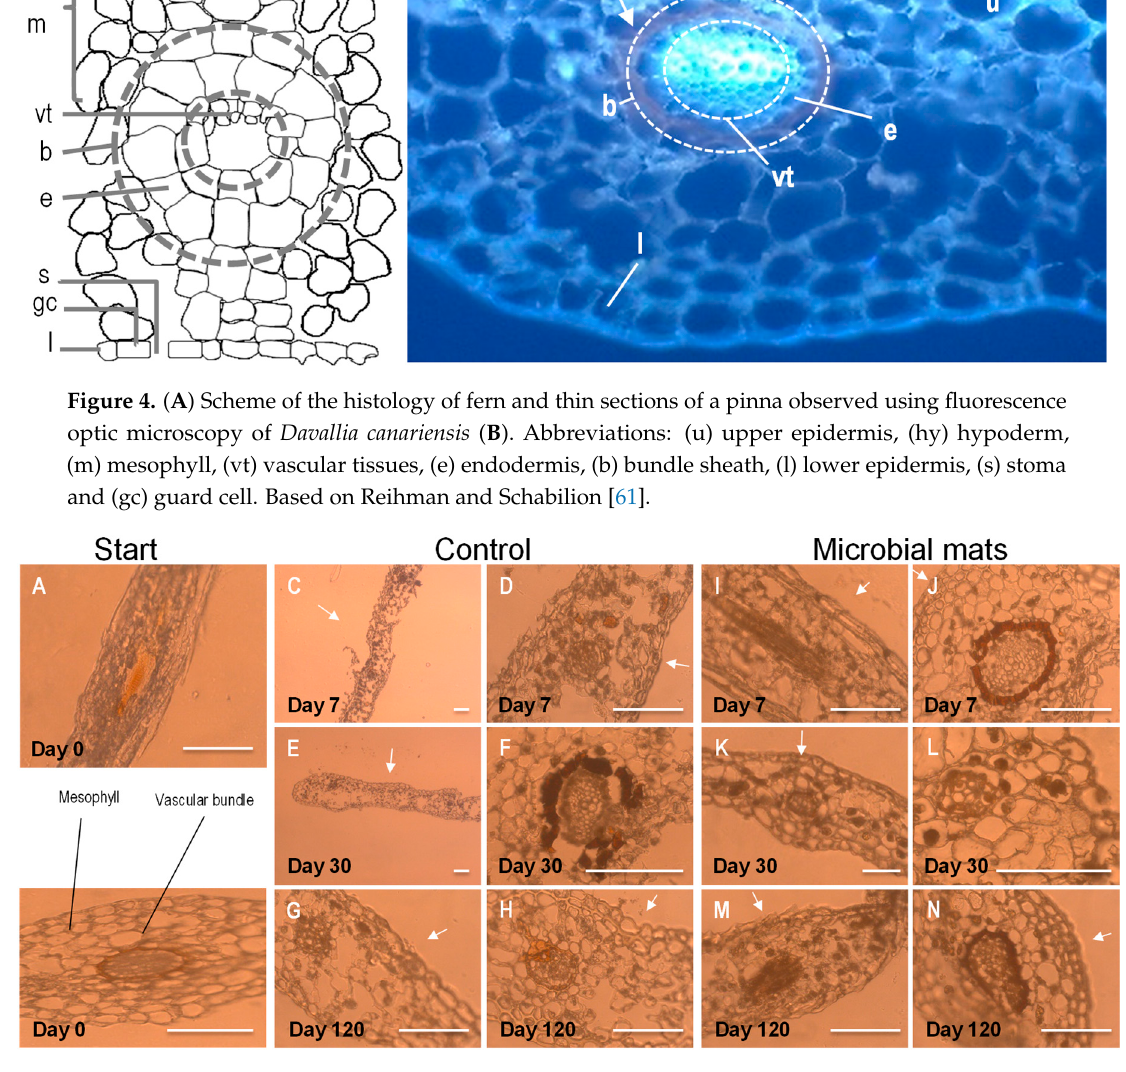
Figure 5. Observation of thin sections of pinna at the beginning of the experiment using a Clear-Field Optic Microscope ( A , B ) and the evolution of controls at days 7, 30, and 120 ( C – H ) and samples from tanks with microbial mats ( I – N ). The white arrows point to the upper side of the pinna. Scale bar: 200 µm.